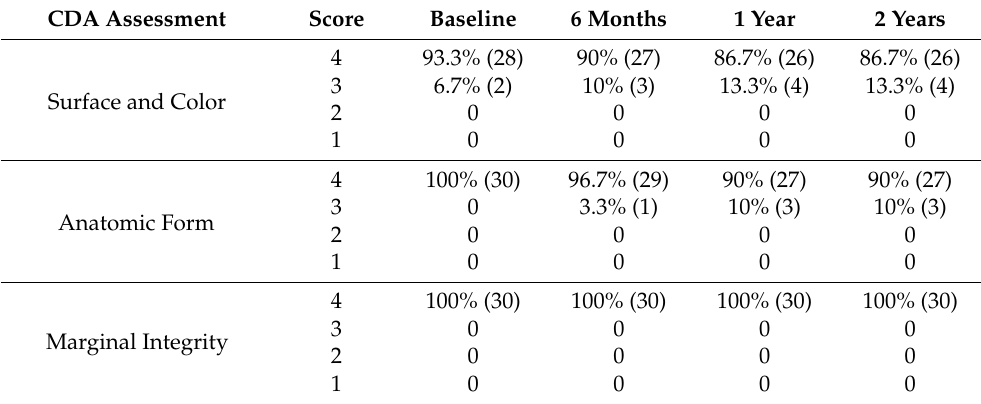
Table 2. Frequency (%) (number) of CDA evaluations at different follow-up periods.